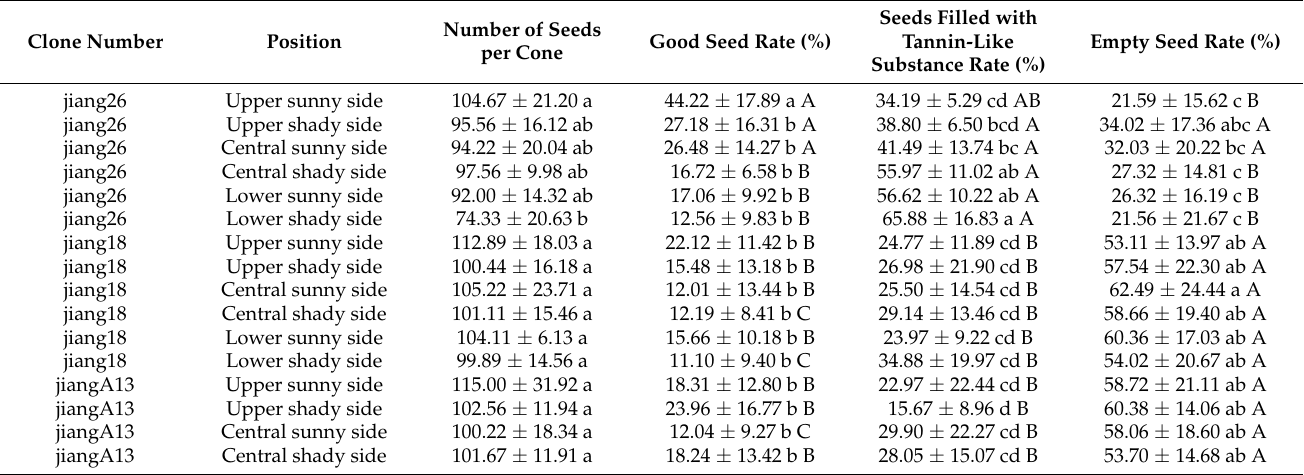
Table 2. Distribution of different quality and types of seeds in different crown layers in the three Chinese fir